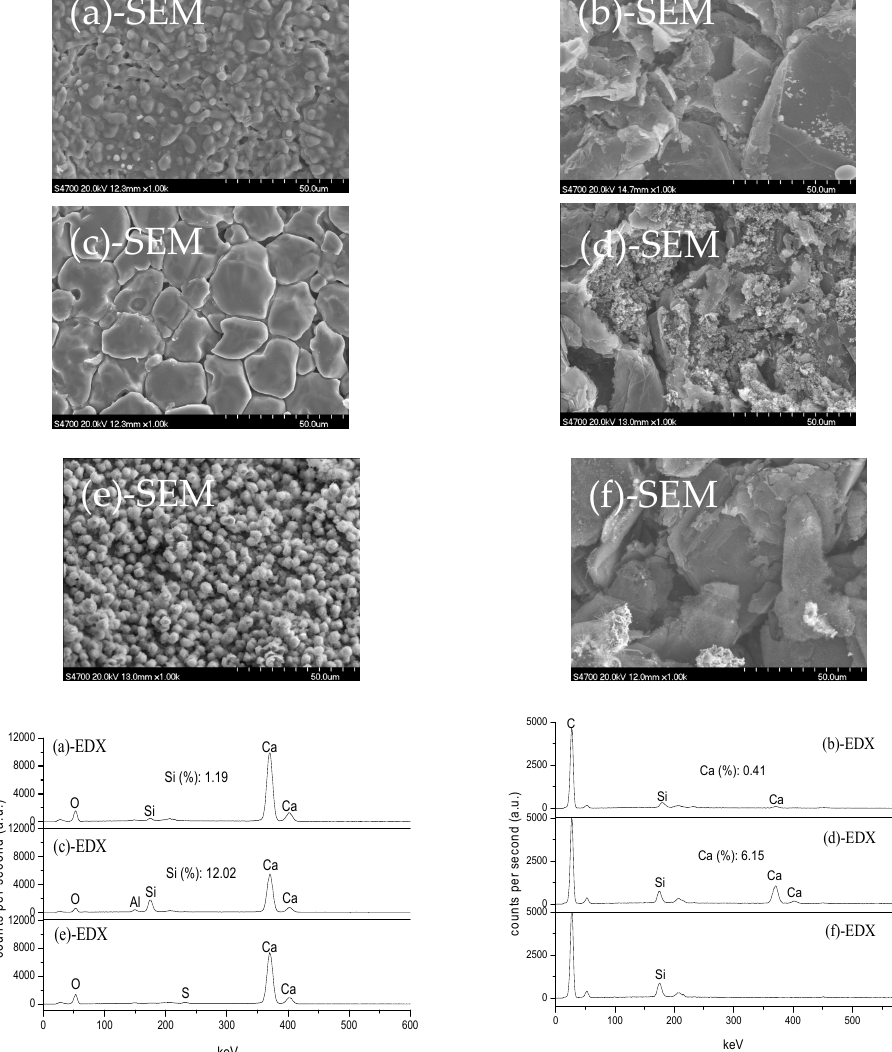
Figure 4. SEM+EDX analyses : ( a ) CaO (1500 °C); ( b ) ash-C (1500 °C); ( c ) CaO (+ash-C,1500 °C); ( d ) ash-C (+CaO,1500 °C); ( e ) CaO (+ash-C,1700 °C); ( f ) ash-C (+CaO,1700 °C).